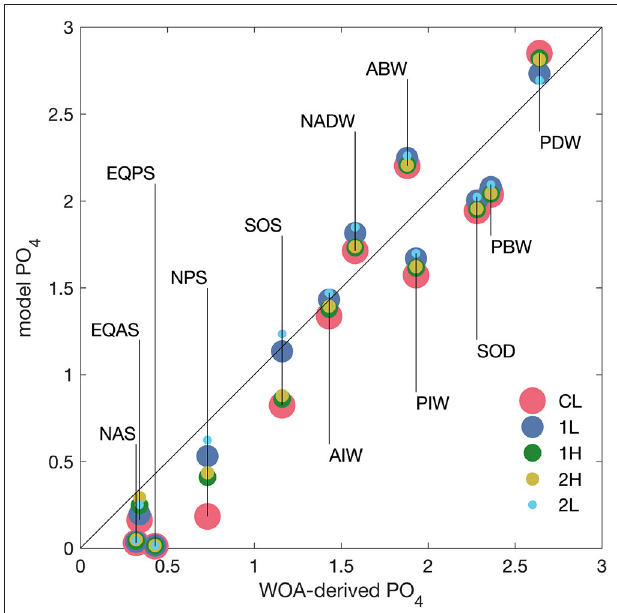
FIGURE 3 | Phosphate concentrations for the 12 model boxes from model results (y-axis) vs. mean concentrations derived from World Ocean Atlas data (x-axis). Acronyms for the model boxes are defined in Table 1 . Red dots show results from the model with constant ligand concentration (run CL ), blue and dark green from the model with one prognostic ligand (runs 1L and 2H ), and yellow and cyan from the two model runs with two prognostic ligands (runs 2H and 2L , respectively). Symbol sizes have been made different to show all values, even if they are